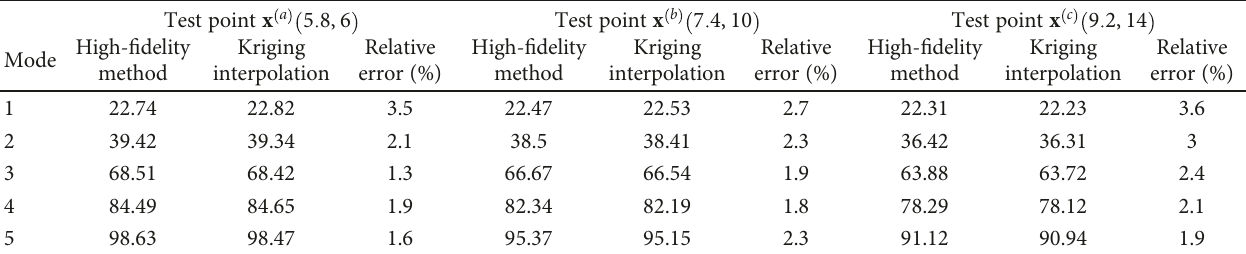
Table 3: Comparisons of the fi rst fi ve modal frequencies at the three arbitrary test points.